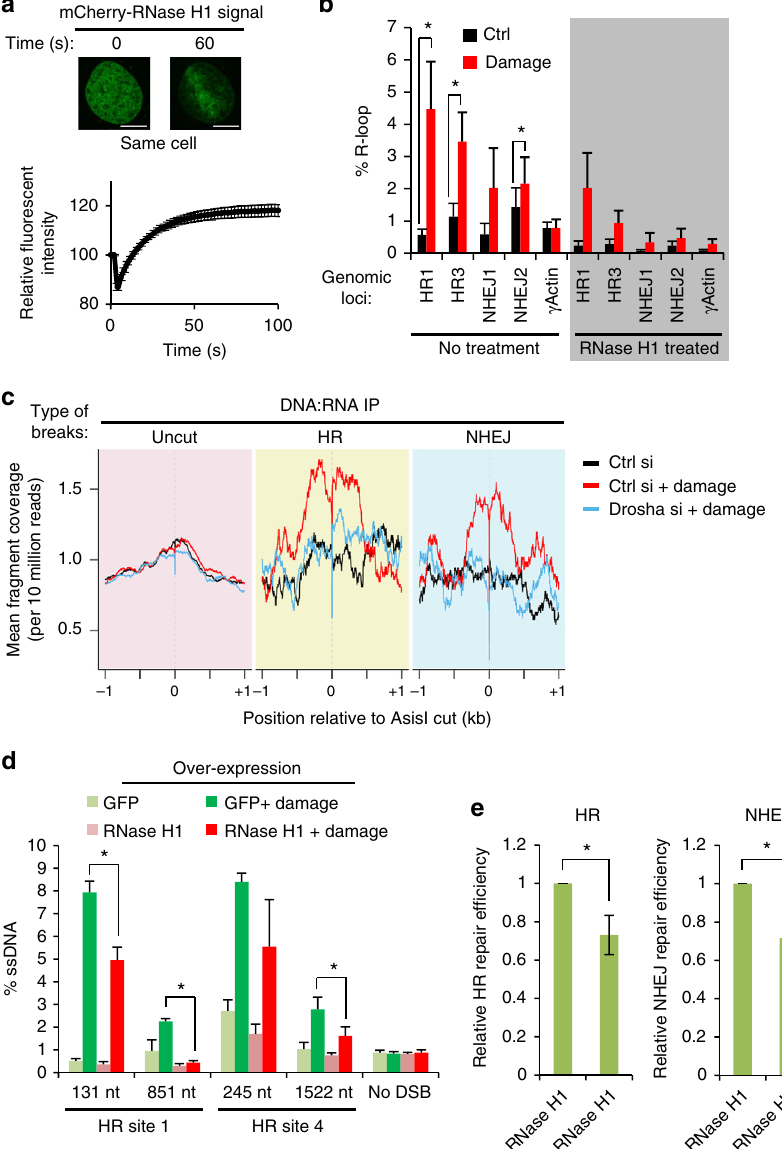
Fig. 7 DNA:RNA hybrids form around DNA break sites to facilitate DNA repair in a Drosha-dependent manner. a Relocation of inactivated E. coli mCherry- RNase H1 D10R E48R to sites of laser-induced DNA damage. Representative fl uorescence images, top. Scale bars, 10 µ m. Bottom, graph showing quantitation of 168 cells over 3 replicates, error bars = SEM. b DNA:RNA hybrid IP (DRIP) followed by qPCR around HR and NHEJ DNA break sites, and control undamaged actin exon 5 locus after 2 h of damage induction. As a positive control, samples were treated in vitro with RNase H1 (shaded section). Error bars = SEM, Student ’ s paired T -test, * p ≤ 0.05 in 4 biological replicates. c DRIP-Seq was performed in conditions as in b . Graph shows enrichment of DNA:RNA hybrids around HR-repaired and NHEJ-repaired cut sites following DNA damage compared to sites documented to remain uncut following damage induction. d Over-expression of RNase H1 or a GFP control was followed by DNA resection assay as in Fig.5 a, b. N = 3, error bars = SEM, Student ’ s 2-sample T -test, ** p ≤ 0.01. e RNase H1 was over-expressed in the HR (left) and NHEJ (right) repair reporter system cell lines (described in Fig. 4a) 6 h prior to I-SceI expression and GFP-positive cells were quanti fi ed as a measure of repair ef fi ciency. N = 3 each, error bars = SD, Student ’ s 2-sample T -test, * p ≤ 2-nucleotide overhang left by the AsiSI enzyme con fi rm that these DNA:RNA hybrids form at actively damaged sites (Supplemen- tary Fig. 14D). Since the DRIP-Seq library preparation includes a step in which 3 ′ -overhang ssDNA fragments are exonucleolyti- cally removed, this shows that the DNA:RNA hybrid forms prior to resection and the resolution of the break. Importantly, the depletion of Drosha abrogates the enrichment of DNA:RNA hybrids around break sites (Fig. 7c, Supplementary Fig. 14B, E, F).